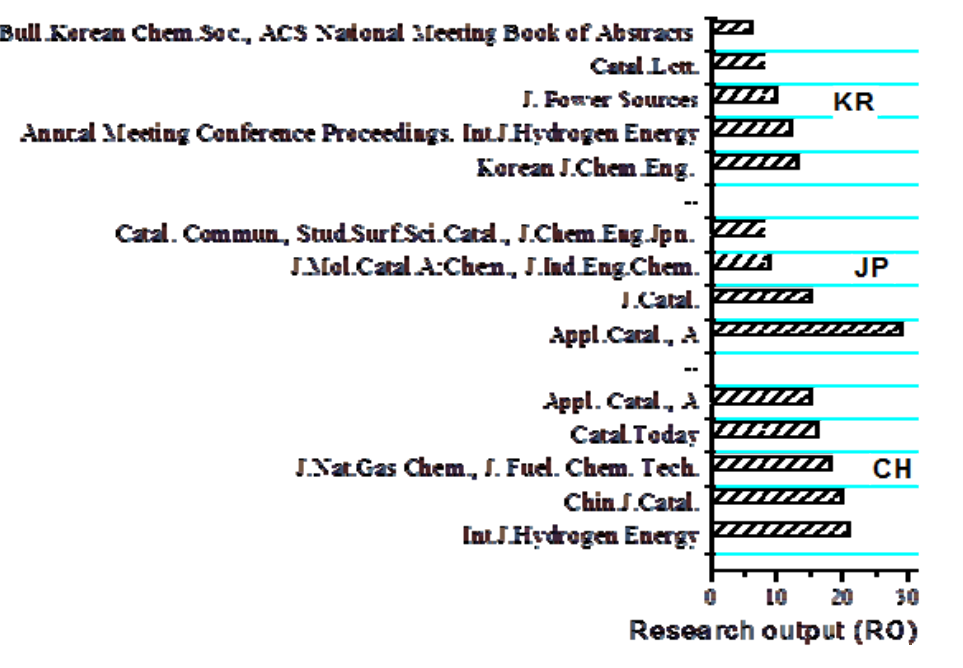
Figure 5. Number of R&D outputs from China, Japan and Korea institutions for selected journals between 1990 and